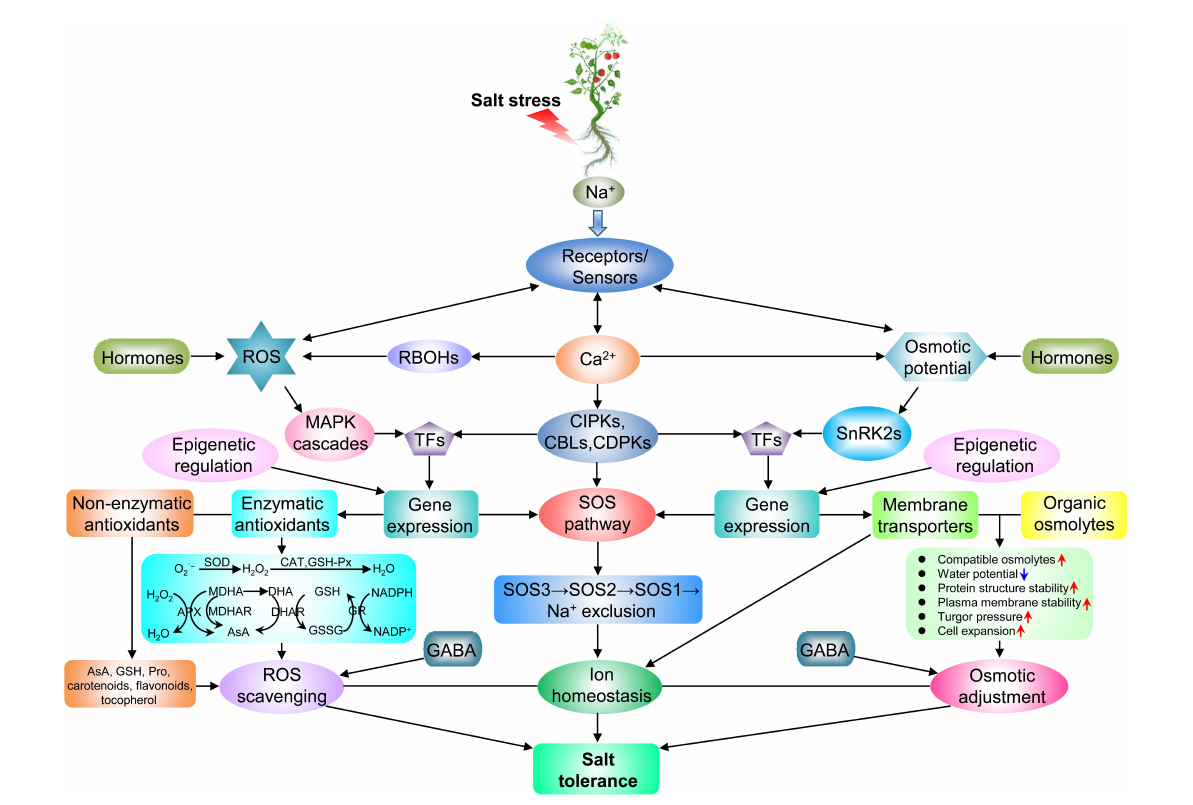
FIGURE2 The potential mechanisms underlying salt tolerance in tomato. Salt stress is sensed by unknown receptors or sensors that act synergistically with Ca 2 + waves, ROS production and osmotic potential. These changes activate antioxidant, ion transporter and osmoregulation pathways, leading to salt tolerance through ROS scavenging, ionic homeostasis and osmotic adaptation. Endogenous GABA participates in ROS scavenging and osmotic adaptation under salt conditions. The red and blue arrows in the box indicate the increase and decrease of the indicators, respectively. APX, ascorbate peroxidase; AsA, ascorbic acid; CAT, catalase; DHA, dehydroascorbate; DHAR, dehydroascorbate reductase; GABA, gamma-aminobutyric acid; GR, glutathione reductase; GSH, glutathione; GSH-Px, glutathione peroxidase; GSSG, oxidized glutathione; H 2 O 2 , hydrogen peroxide; MDHAR, monodehydroascorbate reductase; NADP + , oxidized form of NADPH; NADPH, nicotinamide adenine dinucleotide phosphate; O 2 · – , superoxide radical; Pro, proline; SnRK2s, sucrose non-fermenting-1-related protein kinase 2s;